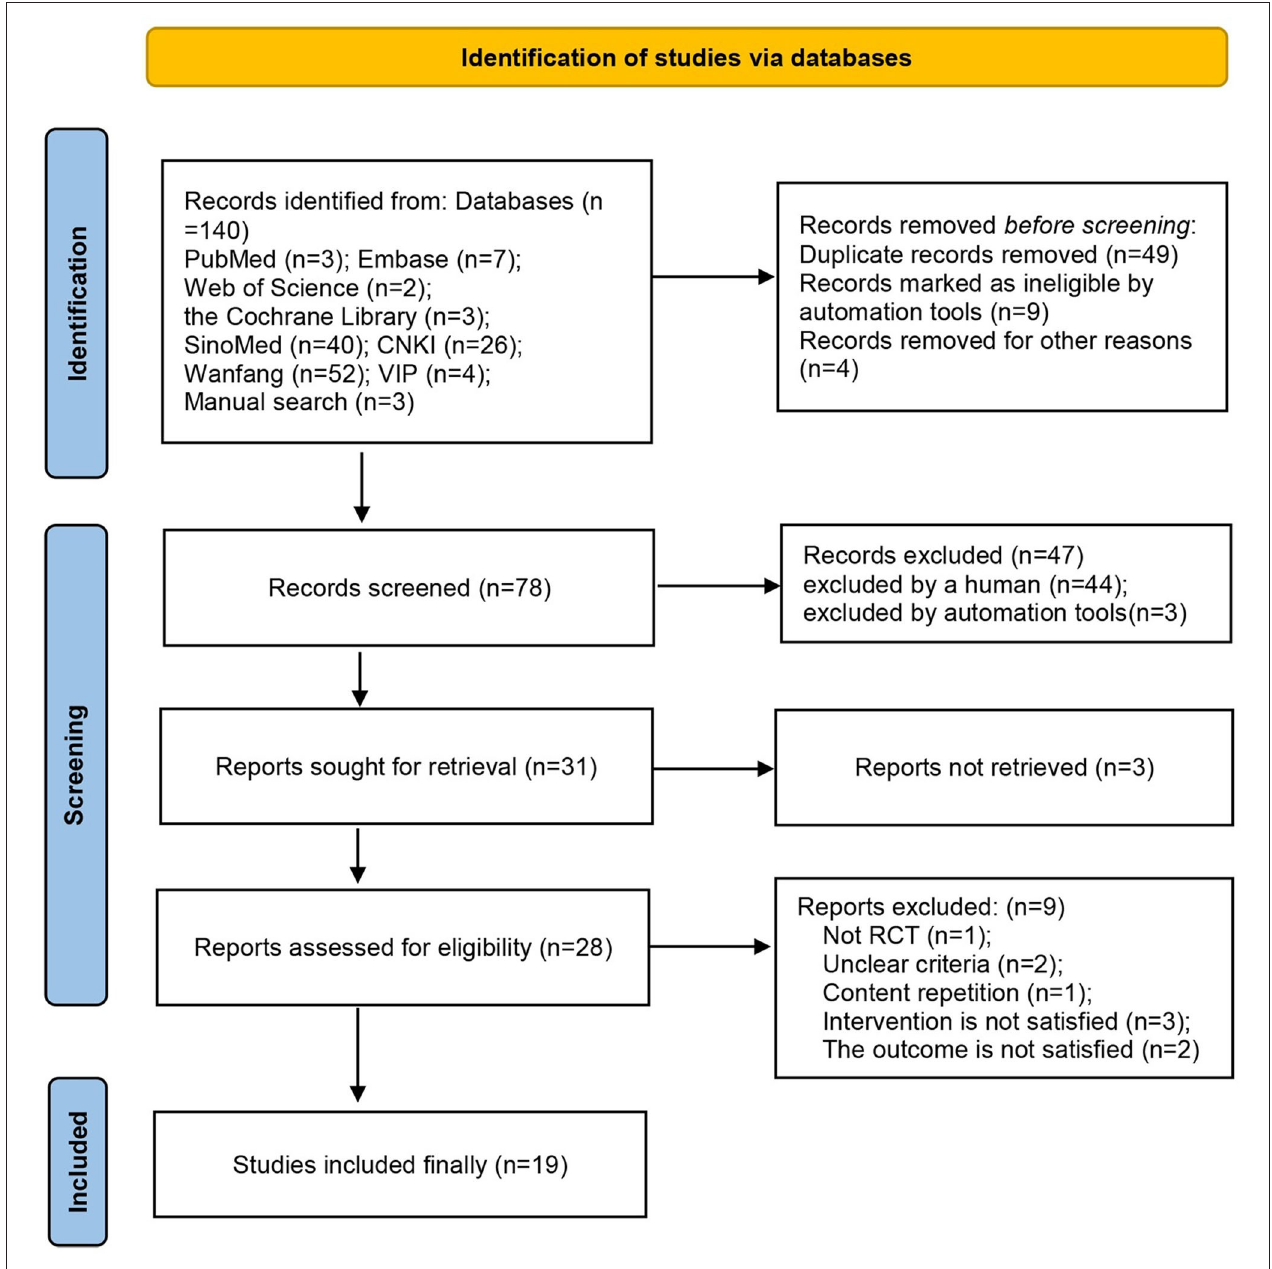
FIGURE 1 | Flow chart of the study.